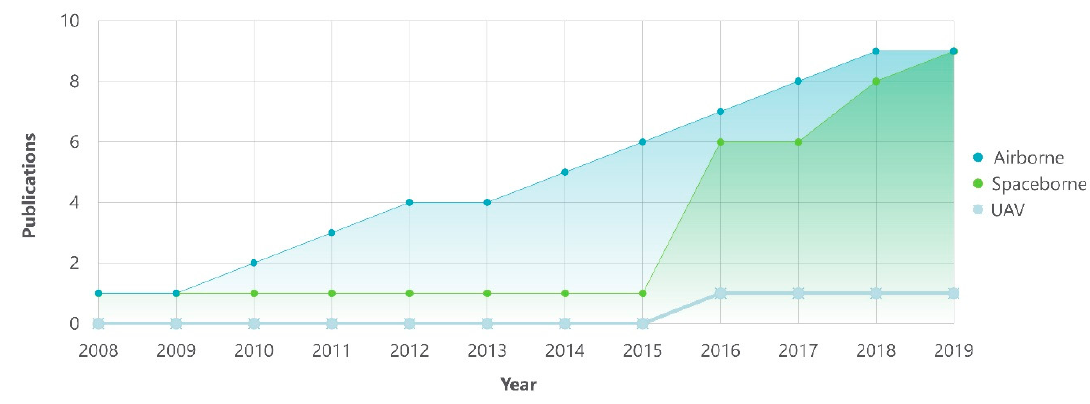
Figure 3. Cumulative illustration of published articles in the last decade (2008–2018) according to the domain of application.